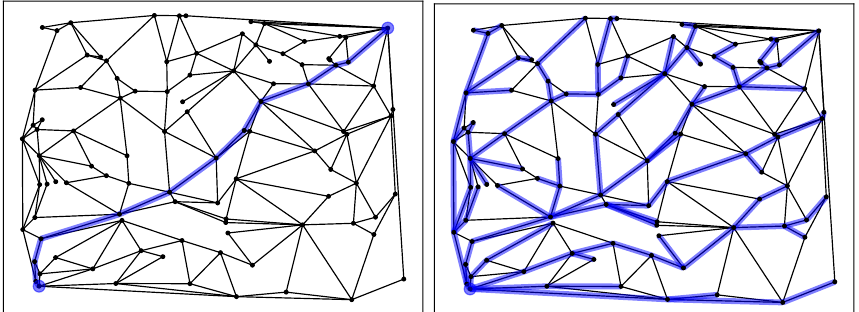
Figure 1. An example graph with n = 100 vertices. In this case, edges are drawn with straight lines and edge weights correspond to the lengths of these lines. This graph is also symmetric in that ( u , v ) ∈ E if and only if ( v , u ) ∈ E , with w ( u , v ) = w ( v , u ) . The ( left ) figure shows a solution to the “single-source single-target” problem, where the source s is at the bottom-left and the target t is at top right. The ( right